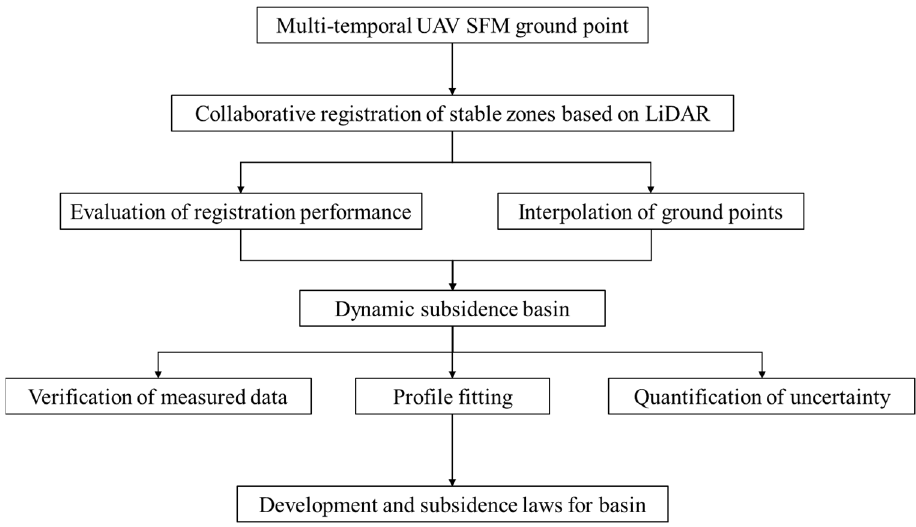
Figure 2. The flow chart for subsidence monitoring via UAV.